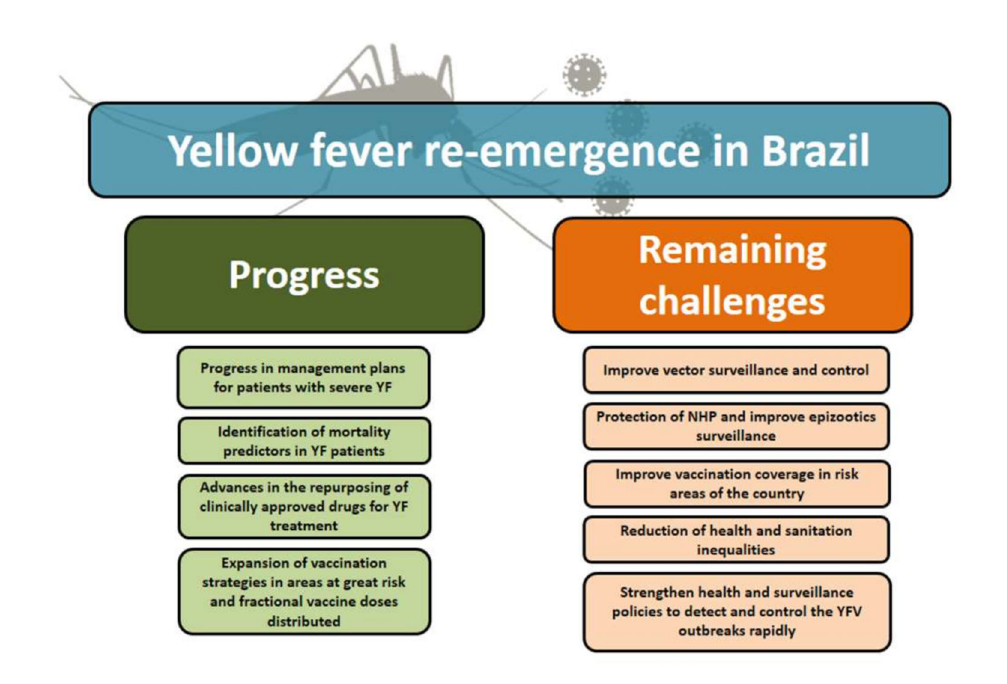
Figure 4. An overview of the YF re-emergence in Brazil. The flowchart highlights some progress that can be recognized during the 2016–2019 epidemic, and the challenges that still need to be covered to contribute to the surveillance and control of YF in